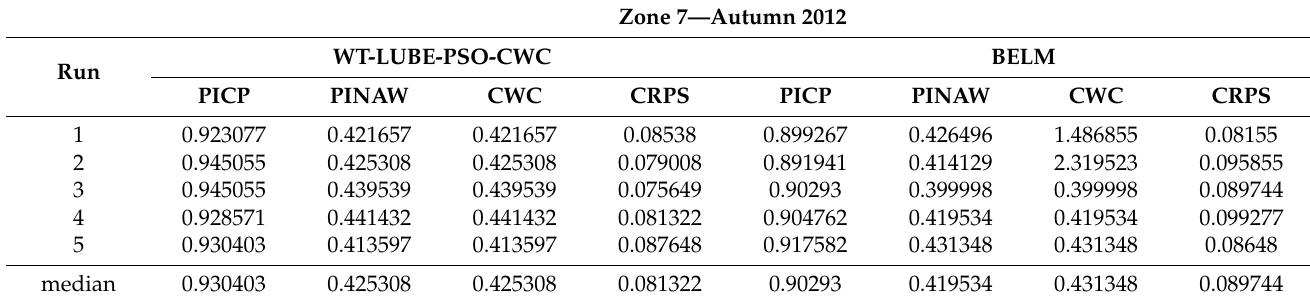
Table 8. Results of the evaluation of 5 training sessions of WT-LUBE-PSO-CWC and BELM models in zone 7 for autumn 2012 at the 0.9 confidence level.